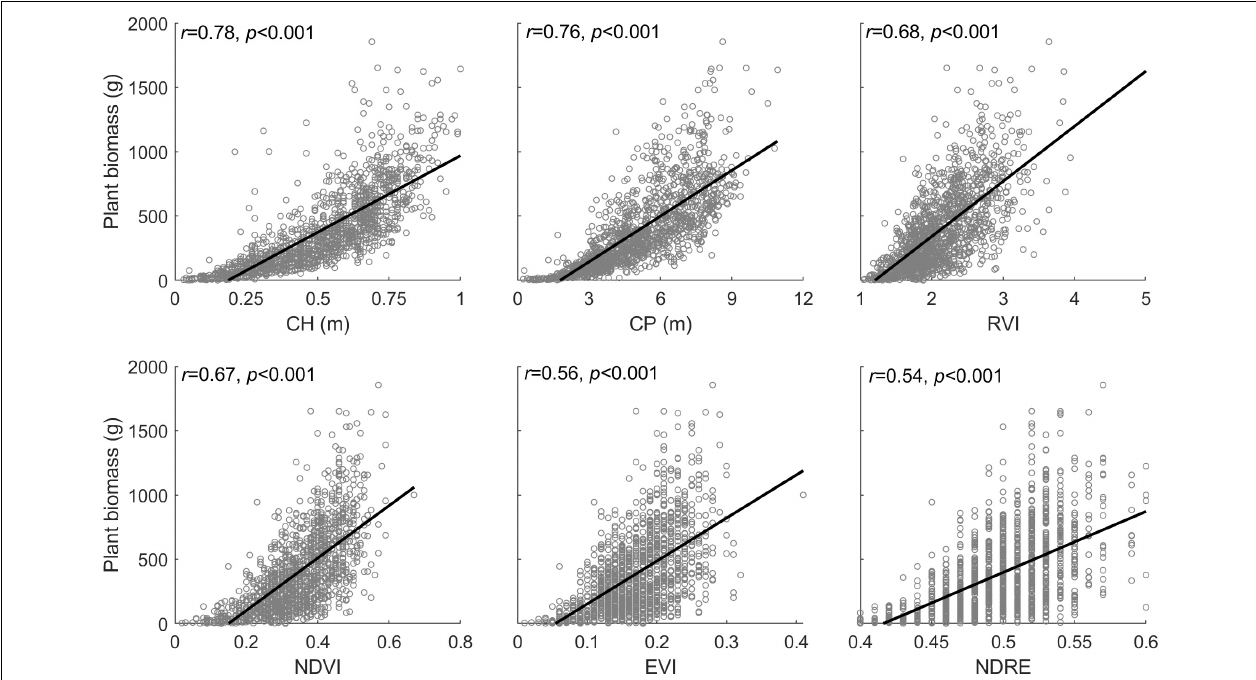
FIGURE 11 | Relationship between the plant phenotyping parameters (CH, canopy height; CP, canopy perimeter), spectral index (i.e., RVI, NDVI, EVI, and NDRE), and plant biomass, where the corresponding data are derived from peak season of plant growth (i.e., September 25,